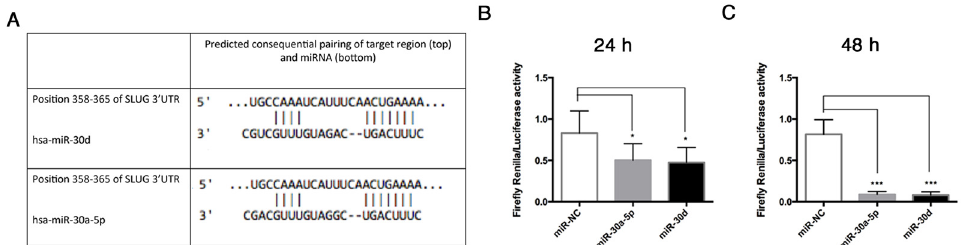
Figure 9. miR-30a-5p and miR-30d target SLUG gene. ( A ) Identification of the putative binding sites of miR-30a-5p and miR-30d in the 3 ′ -UTR of SLUG, as reported by TargetScan analysis. ( B ) 24 h and ( C ) 48 h analysis of Luciferase relative activity in HUVECs co-transfected with pmiR-GLO-SLUG 3 ′ -UTR and miR-30a-5p, miR-30d, or miR-NC. Luciferase activity was normalized to Renilla luciferase activity. The resulting data in HUVECs co-transfected with pmiR-GLO-SLUG 3 ′ -UTR and miR-30a-5p, miR-30d, or miR-NC, were normalized to HUVECs co-transfected with empty vector and the respective oligonucleotides. Results are expressed as mean ± SD of four replicates, and statistical analysis was performed by unpaired t test. * p < 0.005, *** p < 0.001. UTR: untranslated region.